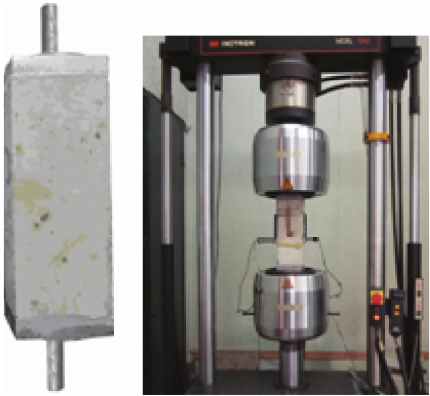
Figure 1: The test device and a typical test specimen.